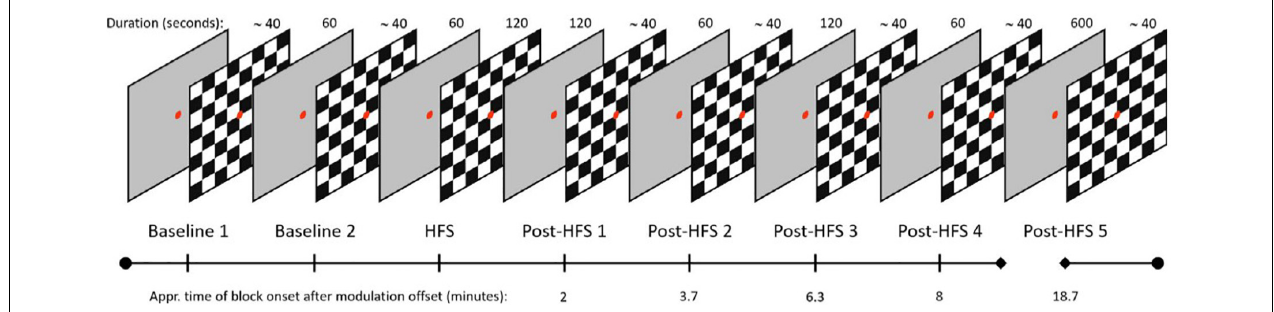
FIGURE 1 | Layout of the VEP paradigm, boxes indicating duration of blocks in seconds, time of block onset after HFS displayed on timeline.